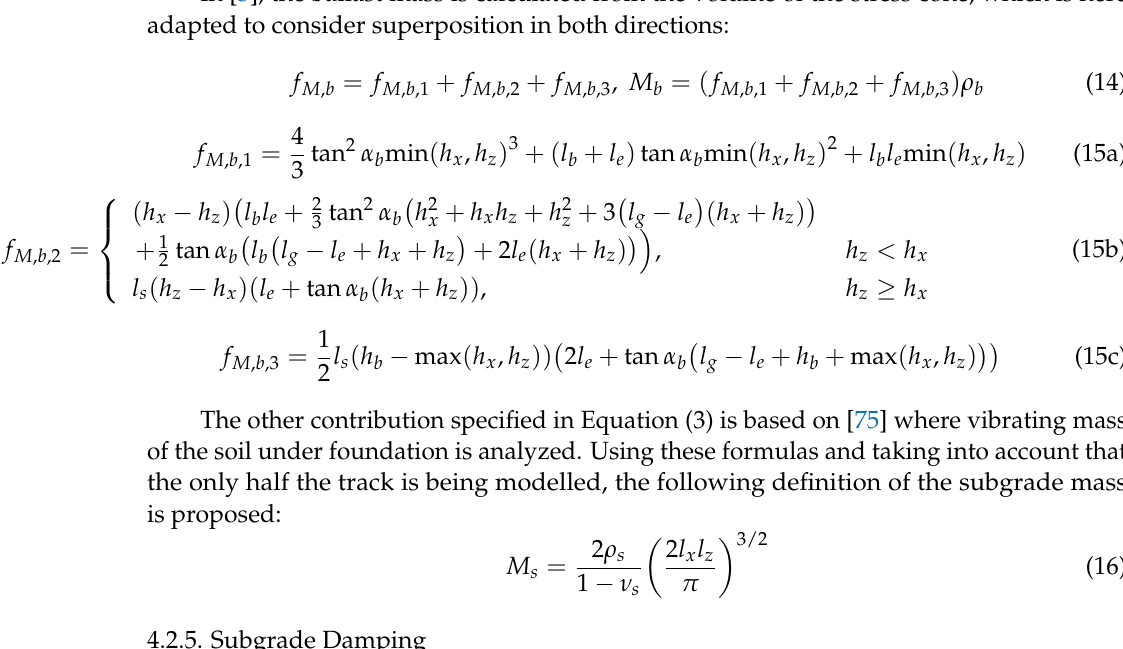
K as a function of K and ( b ) , s P s